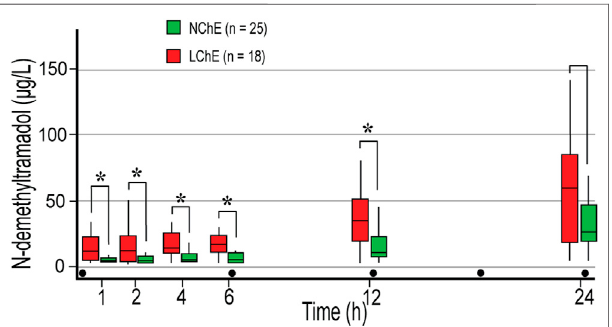
FIGURE 2 | The concentration of N -demethyltramadol in the fi rst 24 postoperative hours depending on preoperative plasma cholinesterase activity in extensive and intermediate metabolizers. Concentrations were measured 1, 2, 4 h after the fi rst dose of 100 mg tramadol iv, and before the second (time point 6 h), third (time point 12 h), and fi fth (time point 24 h) doses of tramadol. LChE, cholinesterase ≤ 4244 U L − 1 ; NChE, cholinesterase > 4244 U L − 1 ; dot, tramadol 100 mg IV injections; * statistically signi fi cant differences (Mann-Whitney U test) between LChE and NChE